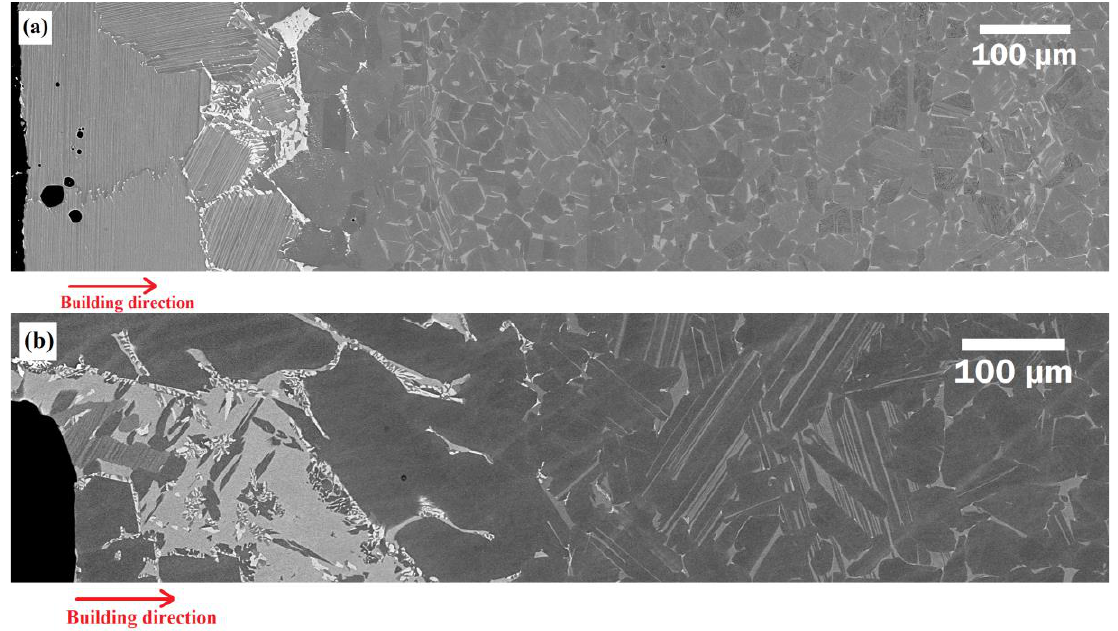
Figure 3. Microstructure of the cross-sections of samples solution annealed at ( a ) 1320 and ( b ) 1360 ◦ °C.